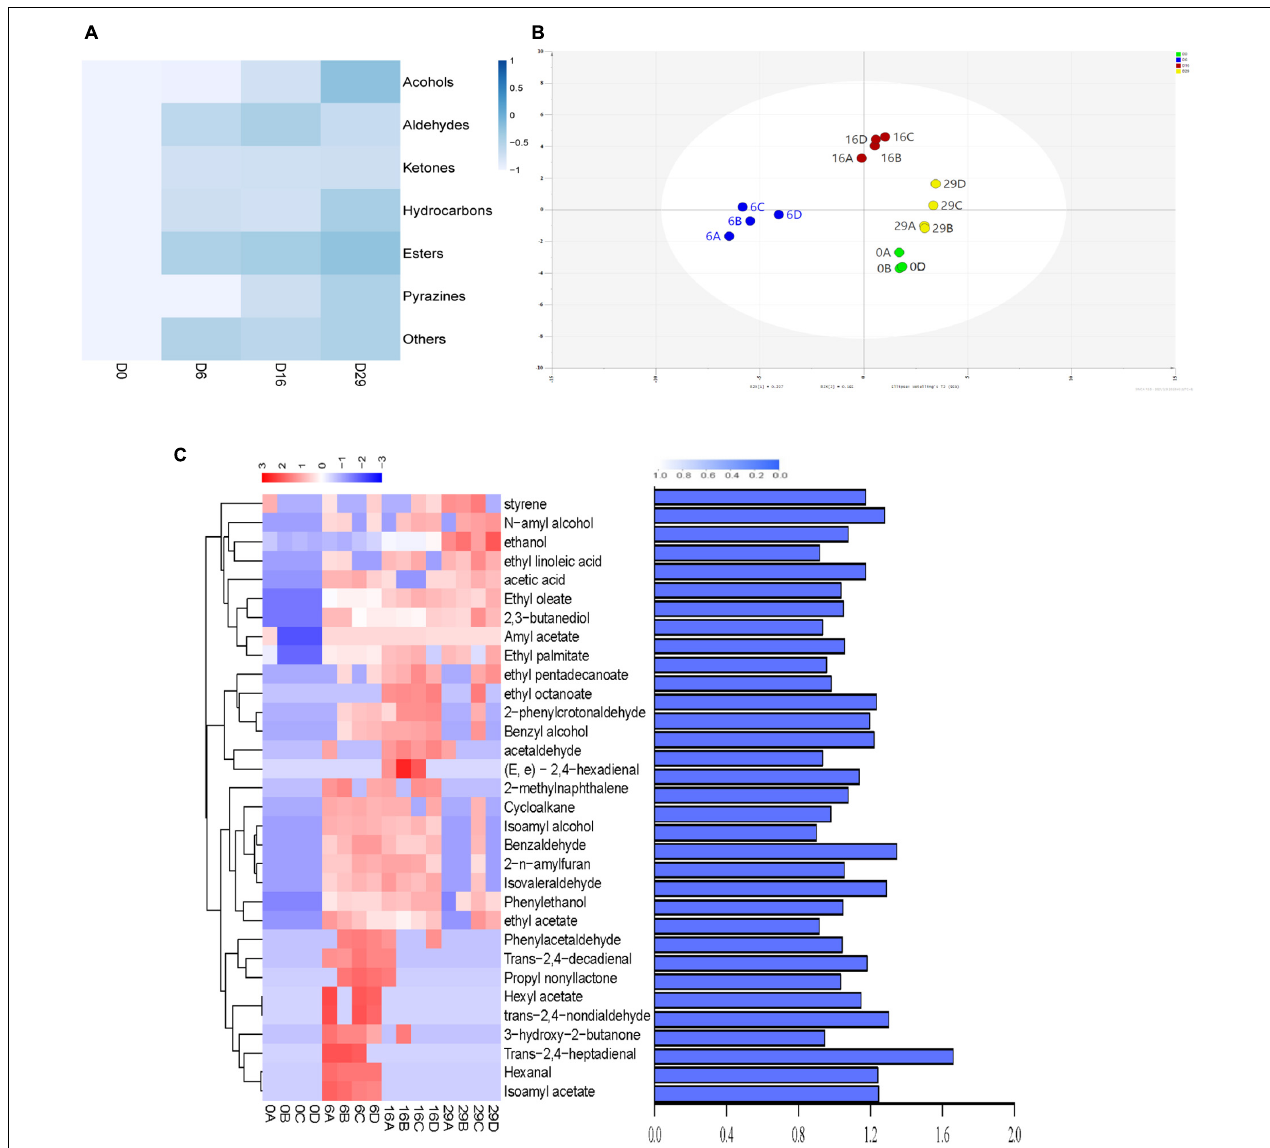
FIGURE 5 | Kinetic comparison of volatile metabolites during fermentation. (A) Heatmap showing the Changes of different types of compounds in the fermentation process. (B) Clustering analysis of the volatile compounds in different fermented samples by orthogonal partial least squares analysis. (C) Distribution of different metabolites and value of variable importance in metabolite projection.